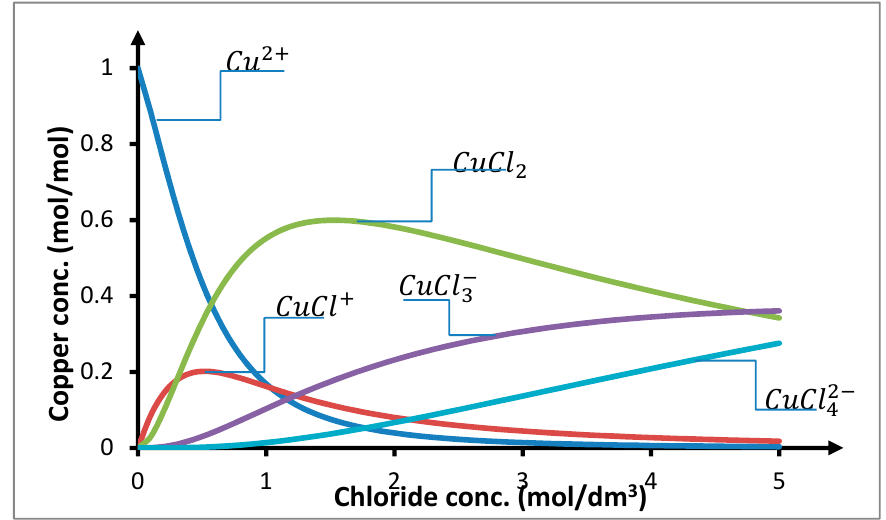
Figure 8. Distribution of copper(II) chloride complexes. Complexation constants of copper(II): log K 1 = 0.06, log β 2 = 0.67, log β 3 = 0.20, and log β 4 = − 0.77 [85].